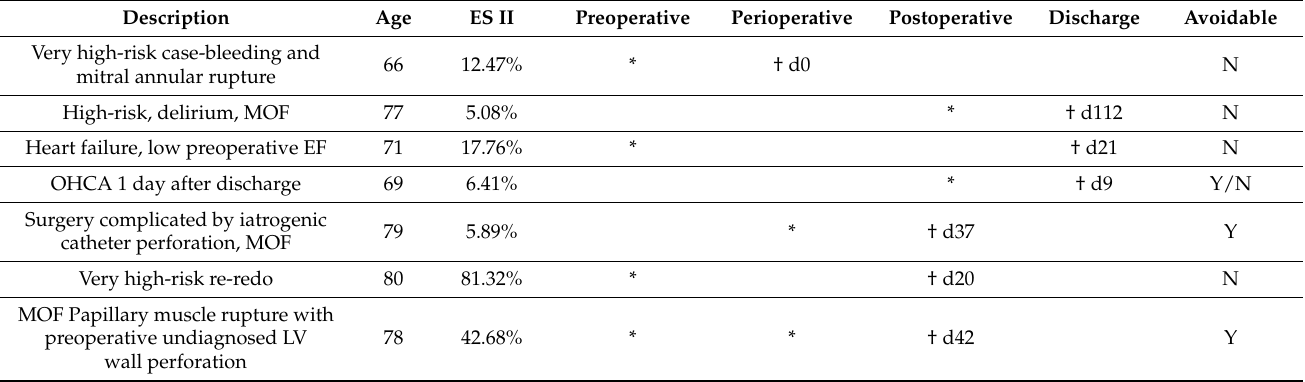
Table 3. Postoperative mortality. ES II: EuroSCORE II, *: adverse event (s), †d: postoperative mortality in days after surgery, MOF: multiorgan failure, EF: ejection fraction, OHCA: out of hospital cardiac arrest, LV: left